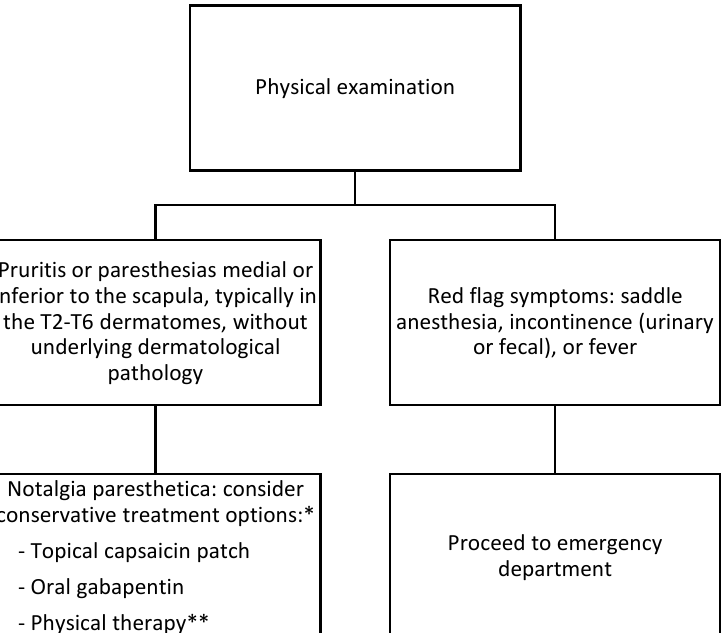
Figure 3. Flow chart detailing the findings in notalgia paresthetica, including conservative man- agement. * There are several conservative treatment options with varying efficacy; representative examples are given as there are no guidelines for treatment. ** Physical therapy can be a supplemental option, especially for patients affected by atrophied paraspinal muscles or who report a shoulder with a reduced range of motion.